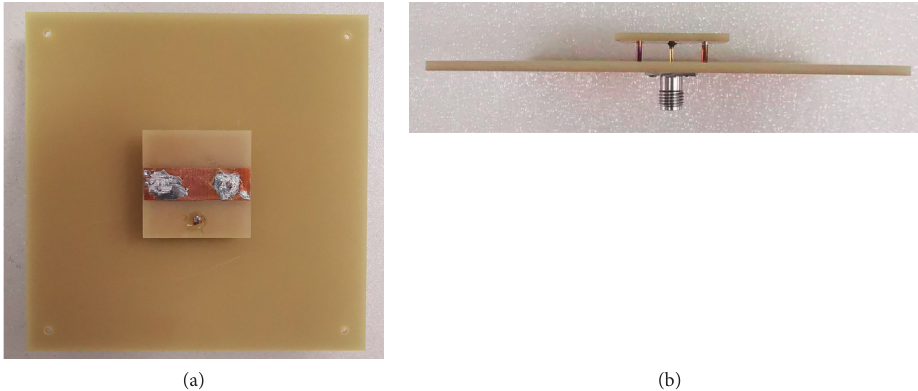
Figure 13: Photograph of the fabricated antenna: (a) top and (b) size view.